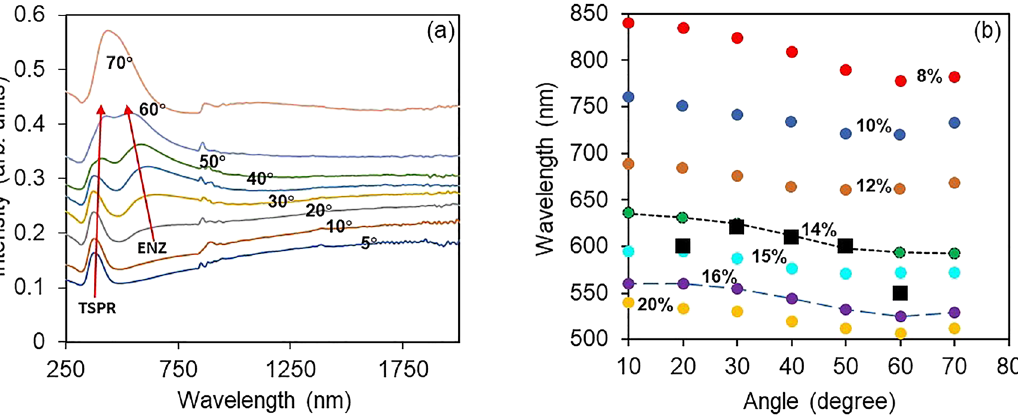
Figure 3: Reflection and dispersion (a) Reflection spectra of arrays of Ag nanowires grown in pores of alumina membrane taken in p polarization at different incidence angles. (b) Dependence of the ENZ reflection maximum on the incidence angle. Large black squares – experiment, other sets of characters – calculations are done at different fi lling factors f shown in the fi